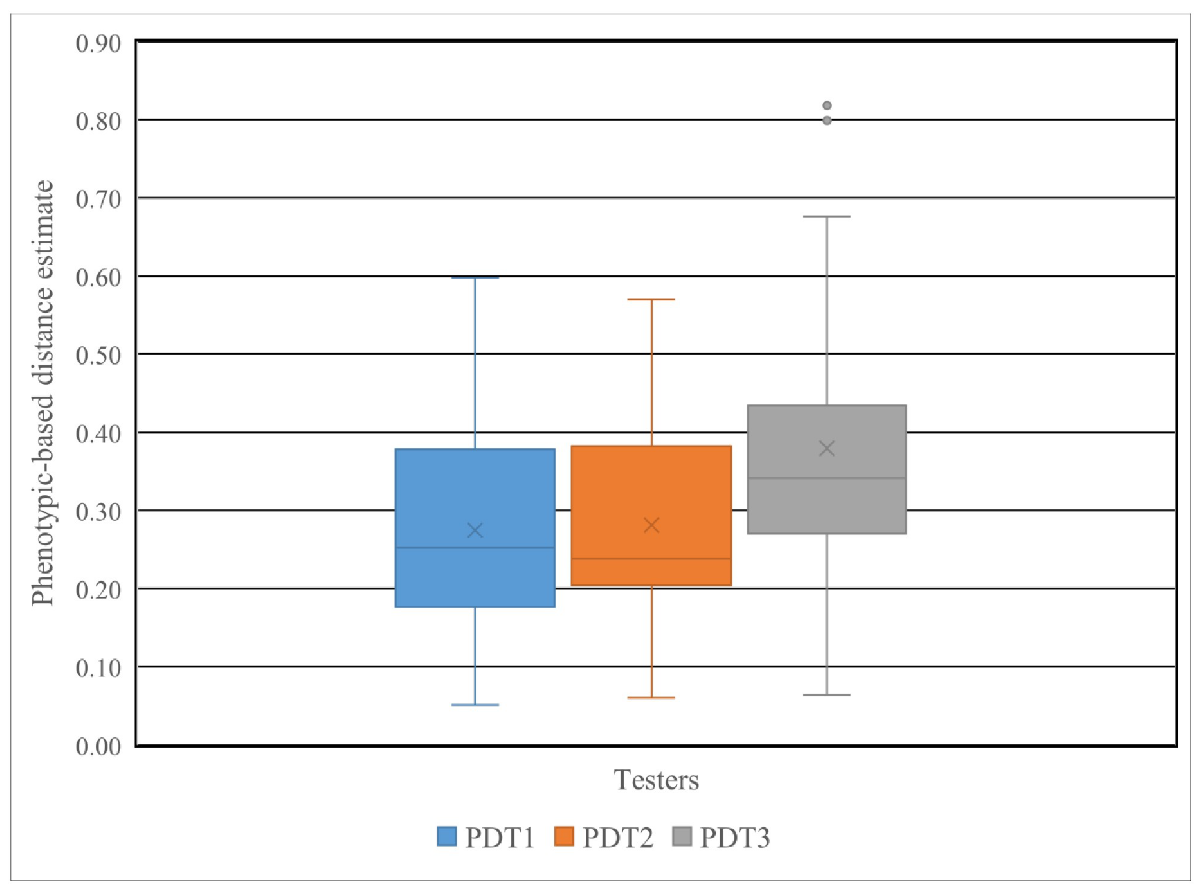
Fig 6. Phenotype-based distance estimates for combinations of 30 Striga resistant yellow endosperm maize inbred lines with each of the three testers ( Striga tolerant tester (PDT1), Striga resistant tester (PDT2) Striga susceptible tester (PDT3)) determined using agronomic data measured under Striga